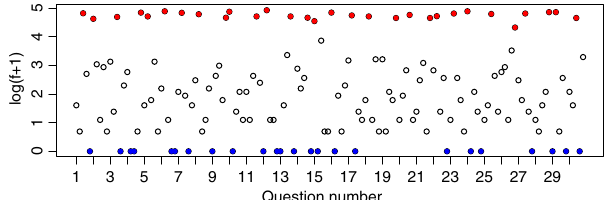
FIG. 4. Normative responses (red) have been chosen much more frequently by students than non-normative (white and blue). In a network, they will become hubs or attractors that yield little information about student thinking. Some responses (blue) have not been chosen at all, and thus do not show up in the response network. Our analysis focus on non-normative responses that have been chosen at least once